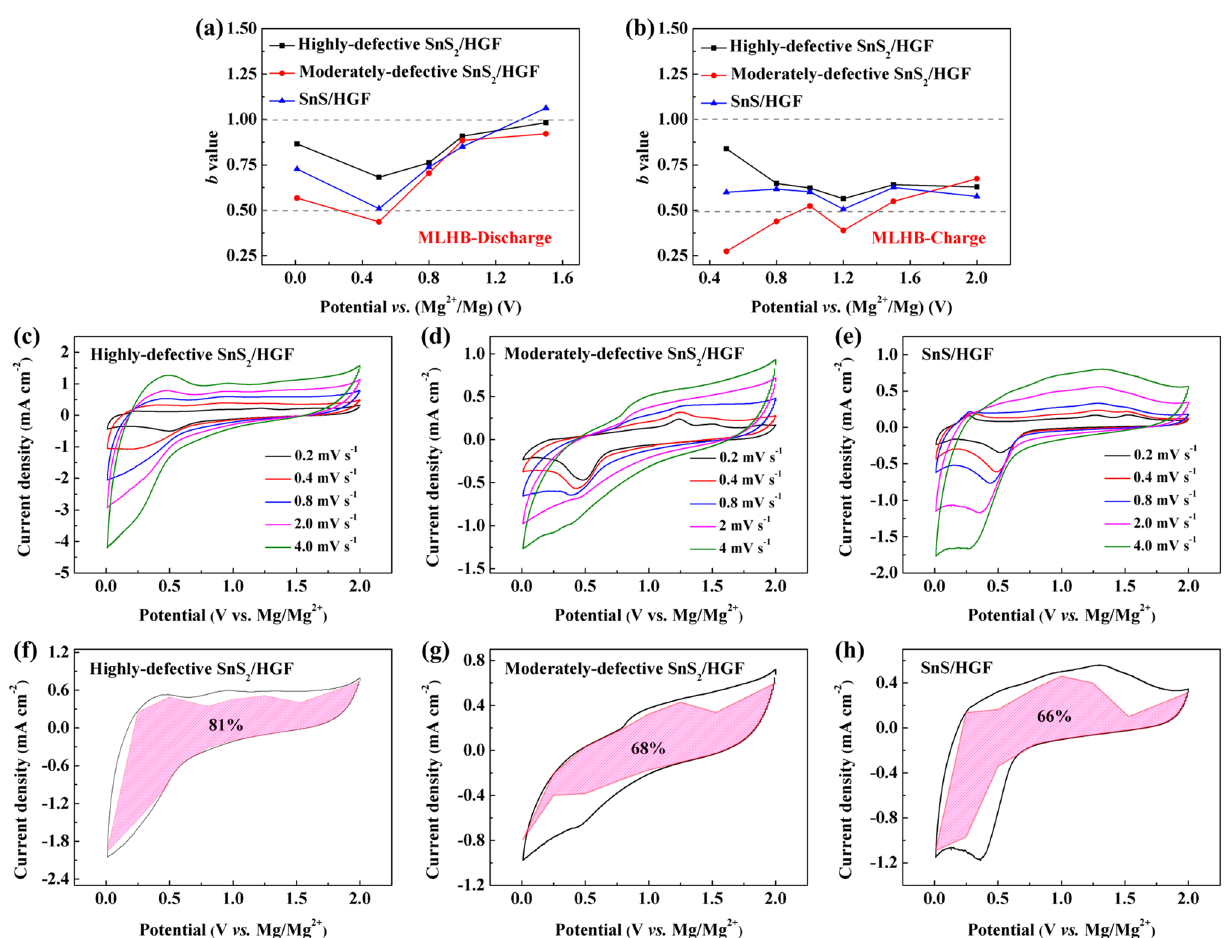
Fig. 8 Kinetics and quantitative analysis of SnS x /HGF in MLHBs. b values of highly defective SnS 2 /HGF, moderately defective SnS 2 /HGF, and SnS/HGF at different potentials versus Mg 2+ /Mg. a During discharging and b charging processes. CV curves of c highly defective SnS 2 /HGF, d moderately defective SnS 2 /HGF and e SnS/HGF at various scan rates, and the corresponding capacitive charge storage contributions of f highly defective SnS 2 /HGF, g moderately defective SnS 2 /HGF and h SnS/HGF at a scan rate of 2.0 mV s.